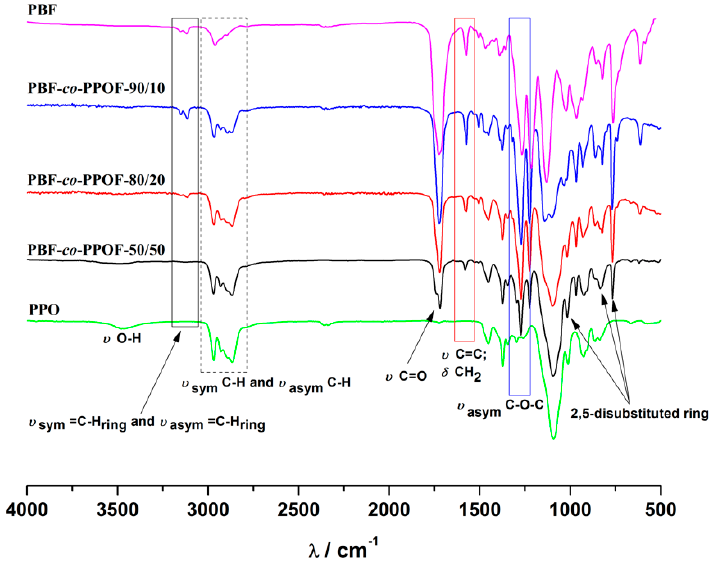
Table 1. Molecular characteristics of PBF and PBF-co-PPOF co-polymers.